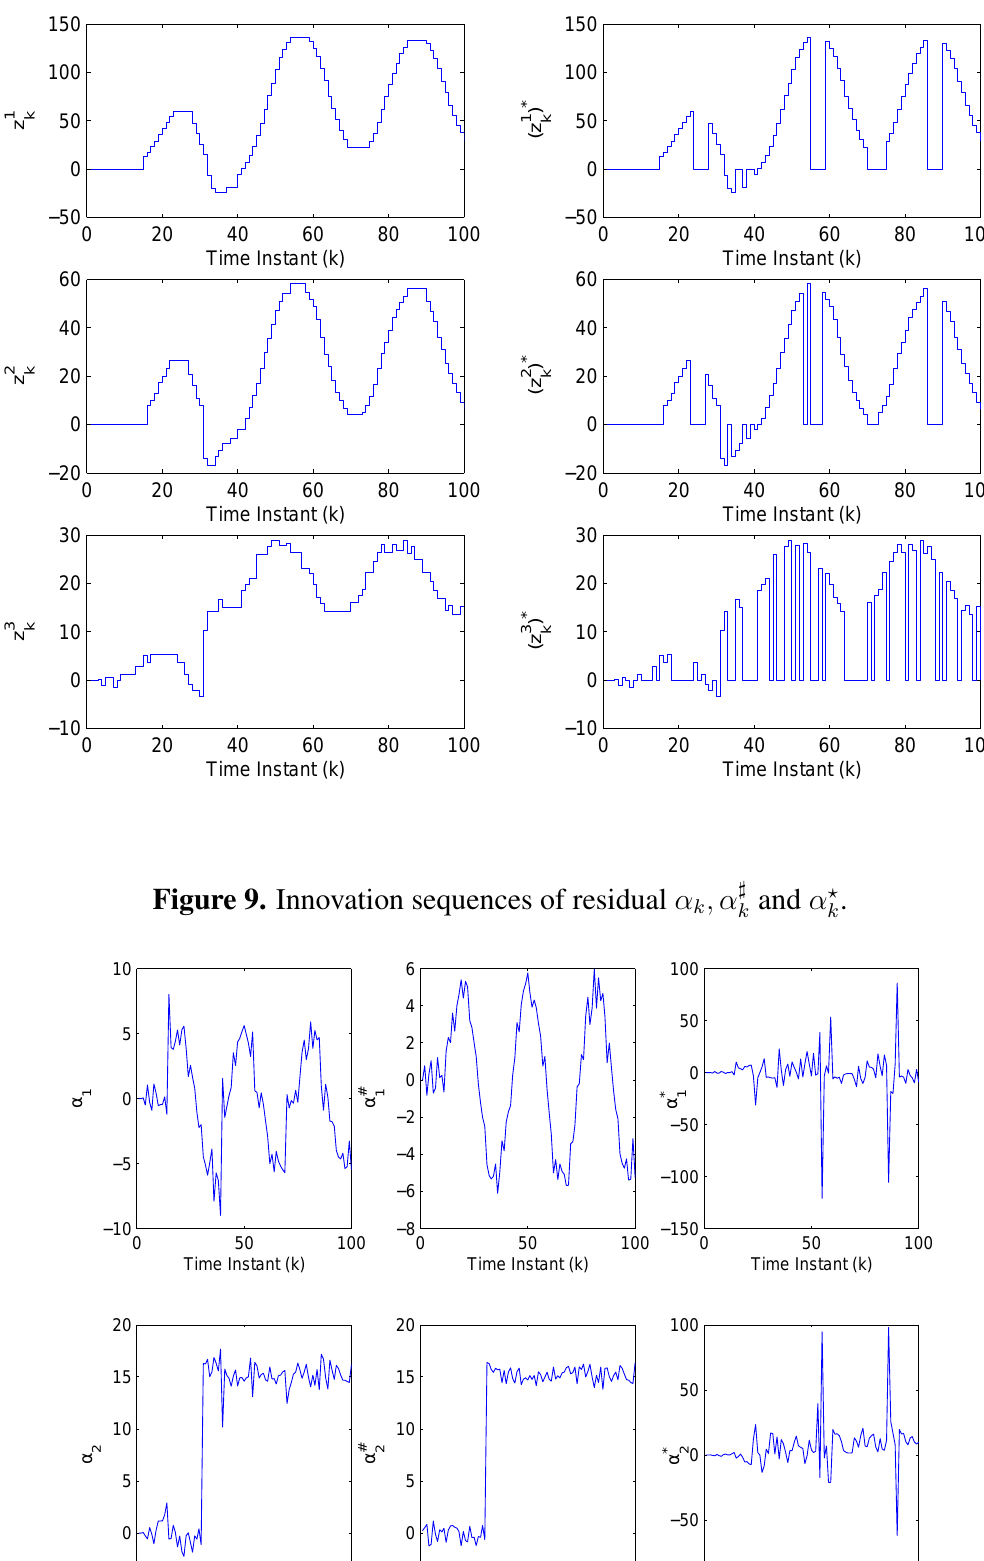
Figure 8. Measurements (a) with compensation and (b) without compensation.